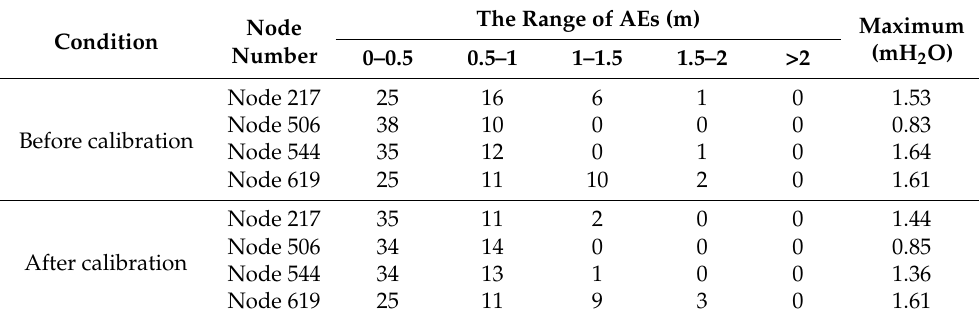
Table 2. The number of time periods in each AEs section before and after